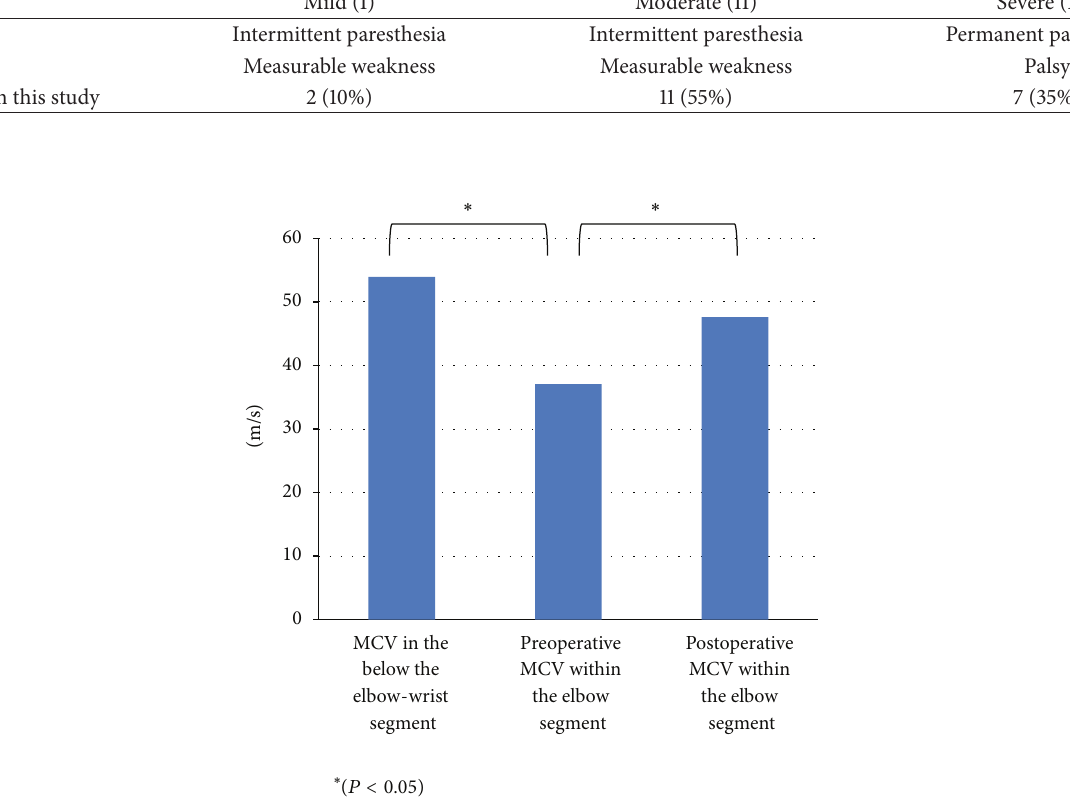
Figure 4: Motor conduction velocity (MCV) result. The preoperative mean value of motor conduction velocity (MCV) was 37.1 ± 6.7 m/s within the segment (above the elbow-below the elbow) and this result showed a decrease compared to the result of MCV with 53.9 ± 6.9 m/s in the below the elbow-wrist segment with statistical significance ( 𝑃 < 0.05 ). Postoperative mean values of MCV were improved in all of 20 patients to 47.6 ± 5.5 m/s ( 𝑃 < 0.05 ).